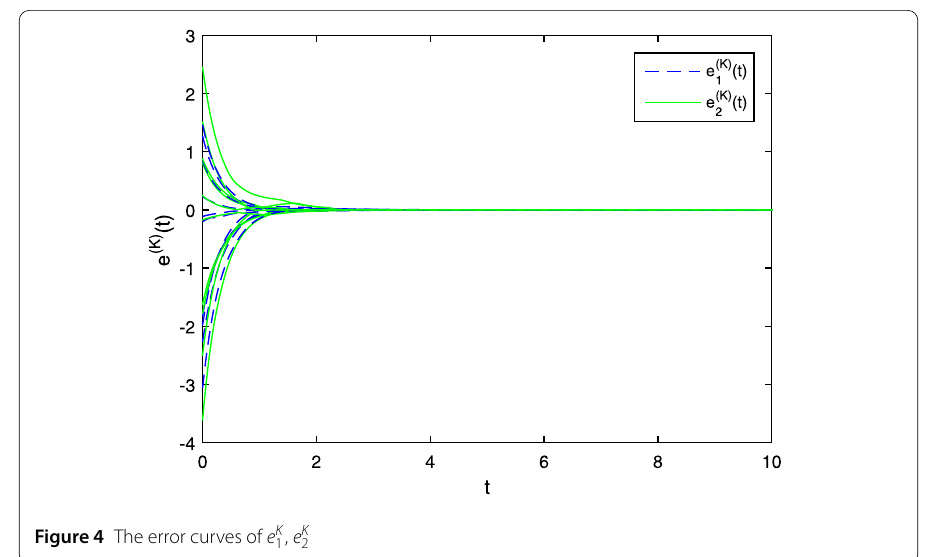
Figure 4 The error curves of e K 1 , e K 2